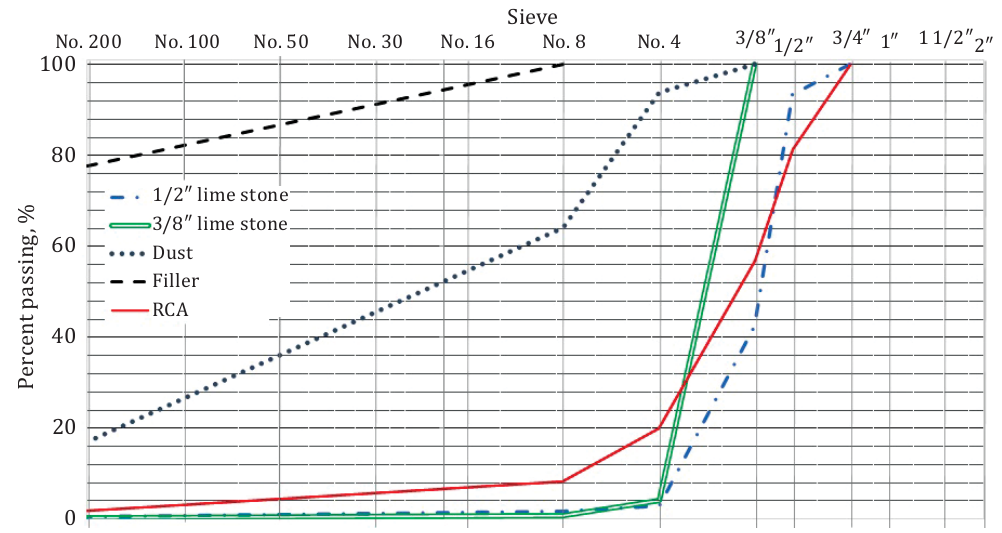
Figure 1. Gradation of the study materials